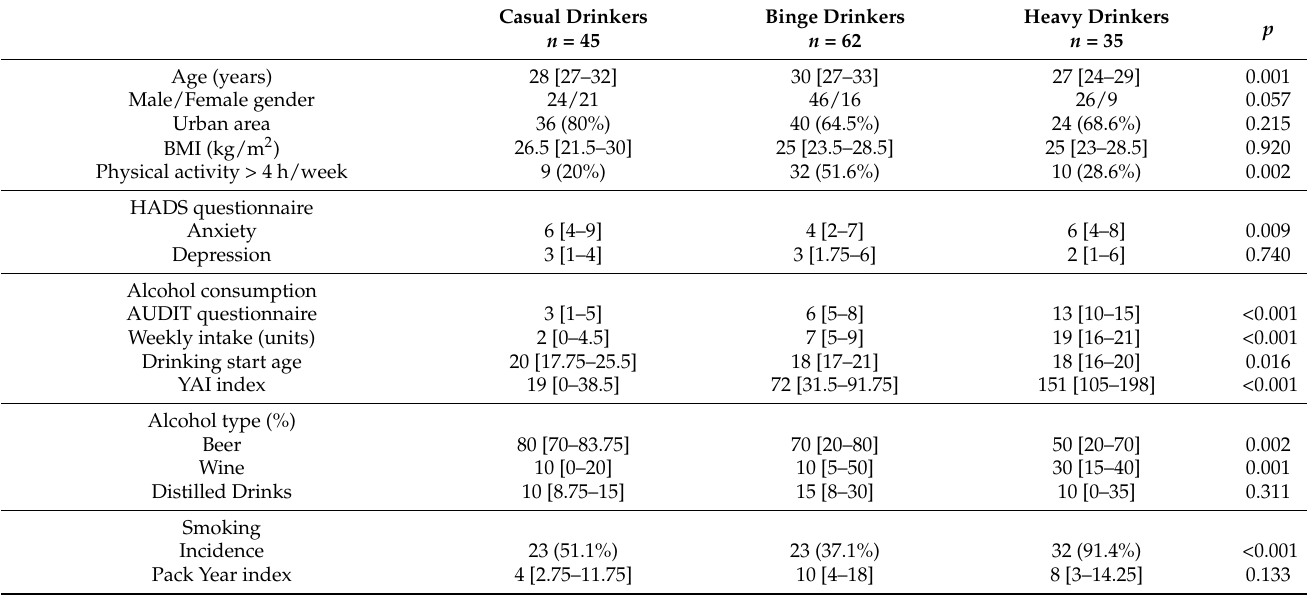
Table 2. General characteristics of the study population ( n =